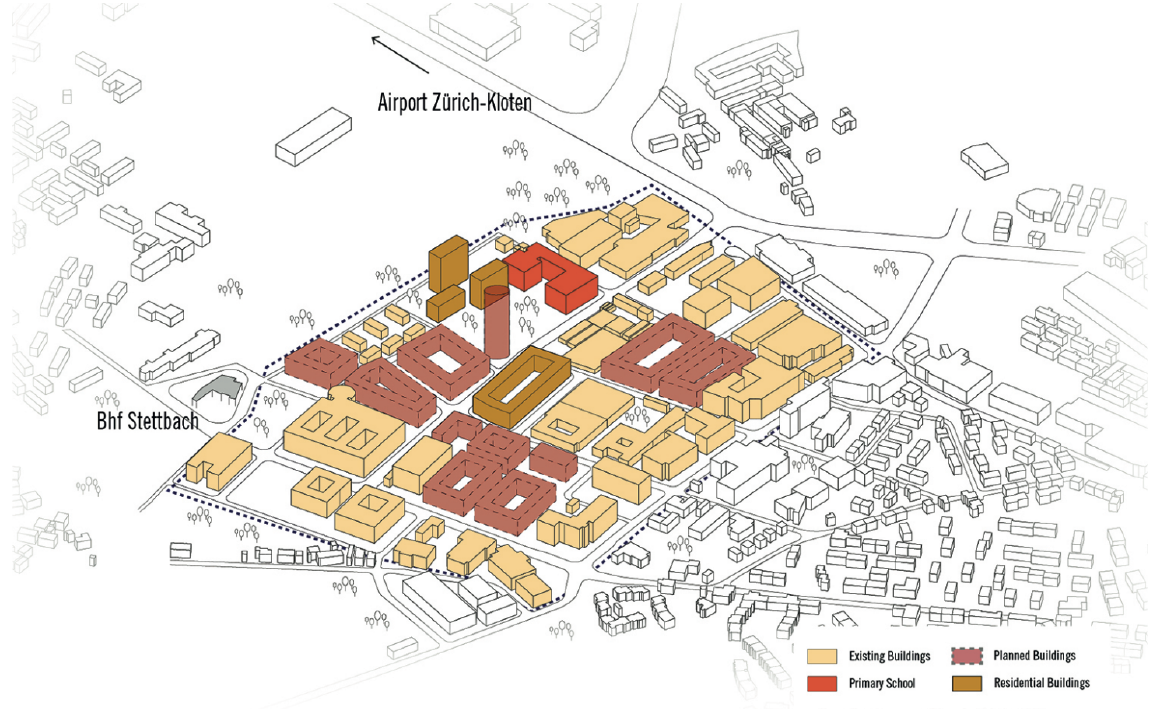
Figure 5. Building structure and distribution of uses for the case study of Hochbord in the city of Dübendorf: the existing commercial and office buildings are complemented by mixed-use typologies and housing. Source: author.